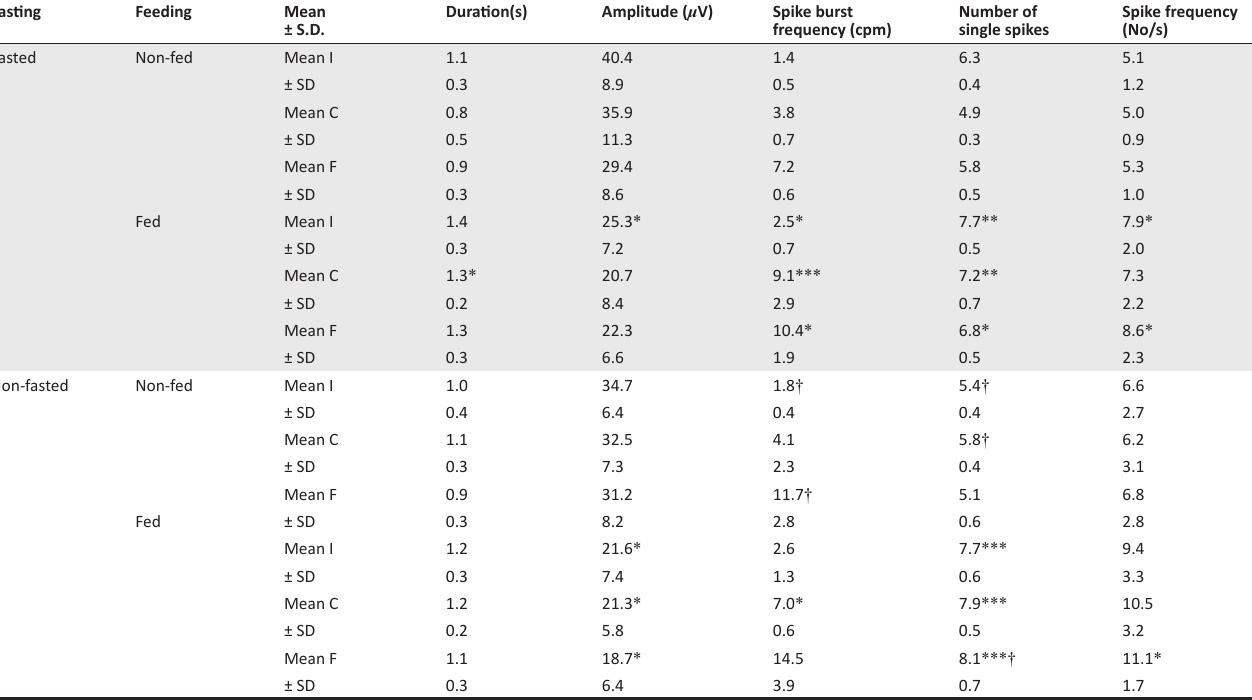
TABLE 1: Characteristics of the short spike bursts recorded during phase 2-like activity of the gallbladder migrating myoelectric complex as observed in the gallbladder infundibulum, corpus and fundus in various feeding conditions. Fasting Feeding Mean ± S.D.